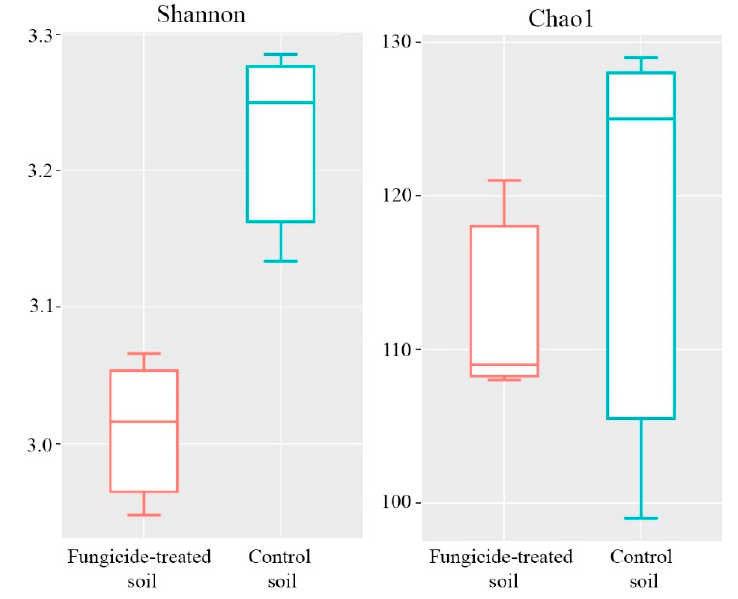
Figure 7. Box plots of the Shannon and Chao1 alpha diversity indices of fungal communities in the fungicide-treated and the control soils. The data represent means of three replicate sequencing reactions. Statistical analysis was performed using the Mann–Whitney test.